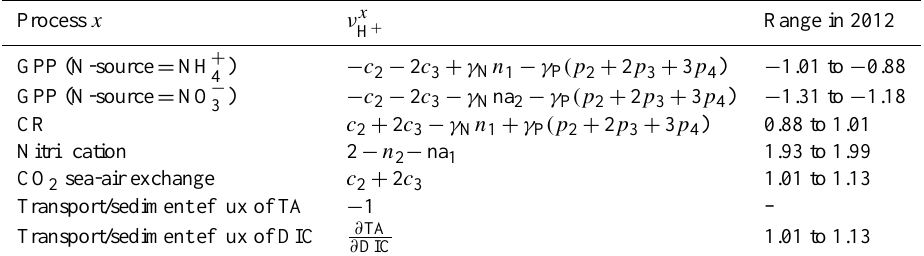
to total ammonia, and p 2 , p 3 and p 4 4